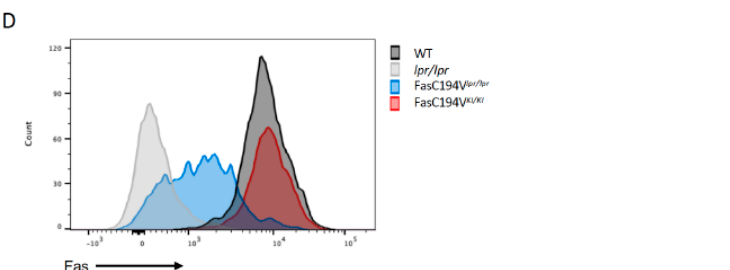
Figure 4. Relationship between Fas clustering and apoptosis induction in T cells. ( A ) Fas-deficient Jurkat cells (RapoC2) were transfected with mVenus-tagged WT or mutant Fas. 24 h post-transfection, cells were treated with increasing amounts of FasL-LZ for 6 h prior to staining with Annexin V, DiIC(5), and Live/Dead, and being analyzed by flow cytometry. ( B ) Activated CD4 + T cells from mice with the indicated genotype were stained for Fas surface expression and assessed by flow cytometry. Data are representative of n = 3 independent experiments. ( C ) CD4 T cells were isolated from mice of the indicated genotypes and activated for 72 h with anti-CD3/28. Cells were cultured with supplemental IL-2 prior to treatment with FasL-LZ at the indicated concentrations for 6 h, then stained for assessment of cell death via flow cytometry as in ( A ). ( D ) CD3/28 activated CD4 T cells from mice of the indicated genotypes were rested in IL-2 and subsequently restimulated with plate-bound anti-CD3 antibody at the indicated concentrations for 16 h prior to assessment for death via flow cytometry as in ( A ). Panels ( A – C ) are cumulative data from a minimum of three independent experiments ( n =